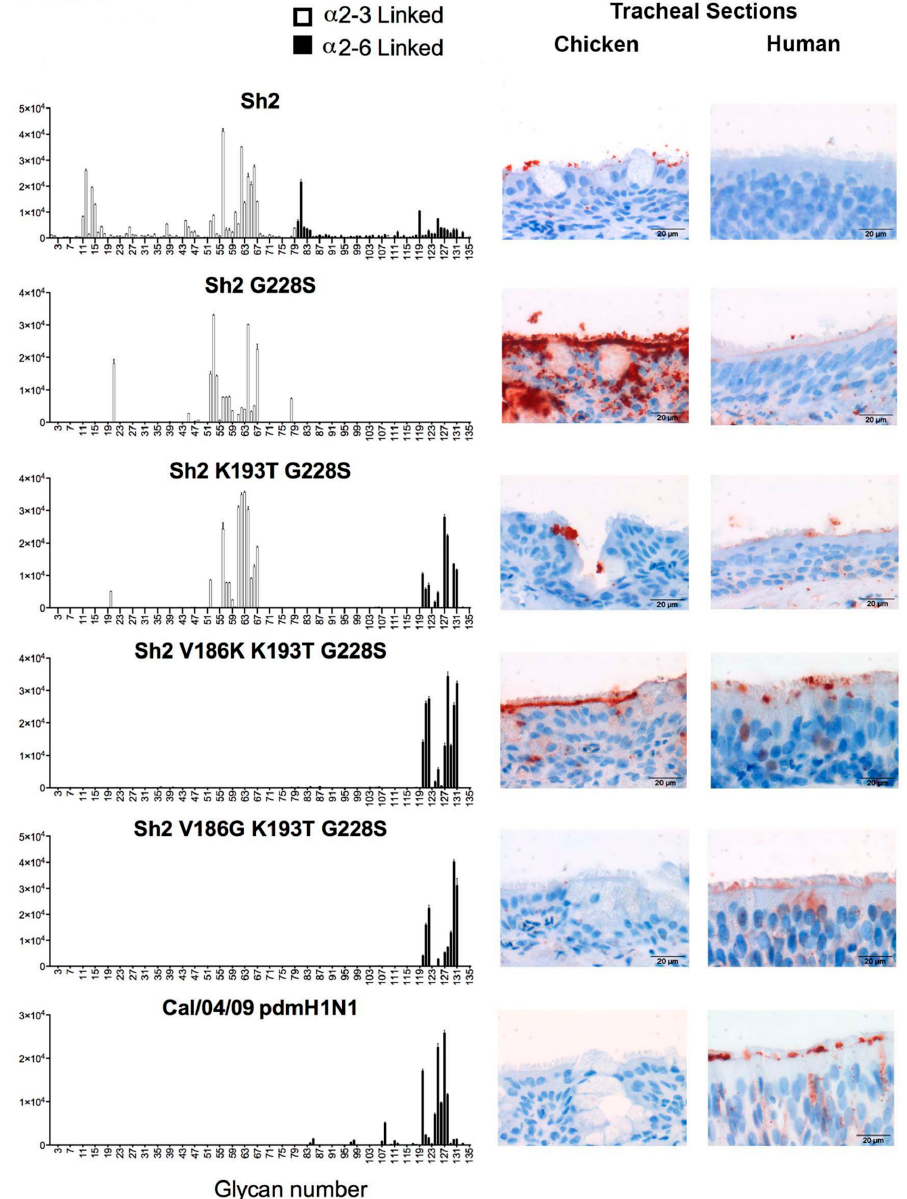
Figure 5. Determination of specificity for wild type (Sh2 = A/Shanghai/2/2013) and mutant H7 HAs on glycan arrays (left) and trachea epithelium (right). Mutations introduced in each glycan array are listed above the plot. Glycans 1 to 10 are non-sialylated controls, while 11 to 79 represent α -2,3 linked sialosides and 80 to 135 represent α -2,6 linked sialosides. The binding profile for triple mutants V186K/G-K193T-G228S is nearly identical to the pandemic control virus Cal/04/09 2009 H1N1. Minimally adapted from the original picture in [31] .